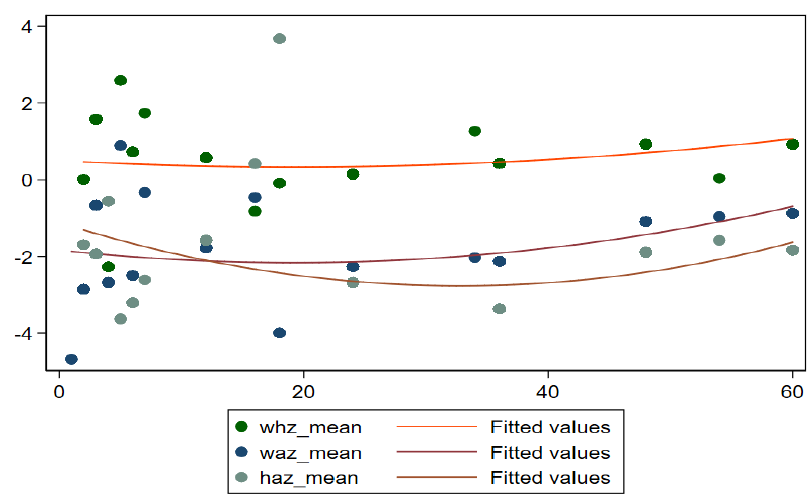
Figure 2. Mean Z−S cores (HAZ, WHZ, and WAZ) by age in months. Figure 2. Mean Z − Scores (HAZ, WHZ, and WAZ) by age in